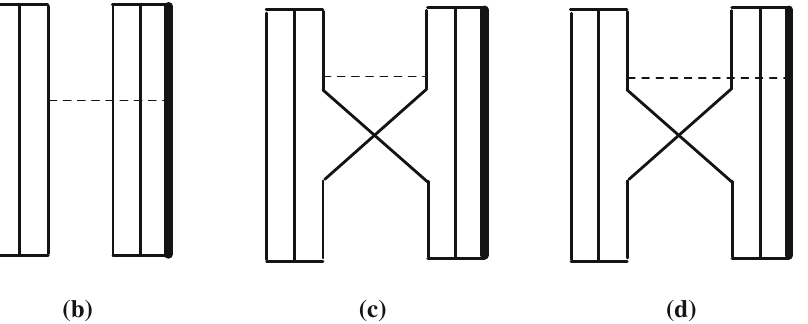
Fig. 1 Representative diagrams contributing to the charmed baryon– nucleon interaction. The vertical solid lines represent a light quark, u or d . The vertical thick solid lines represent the charm quark. The dotted horizontal lines stand for the exchanged boson. a Interaction between